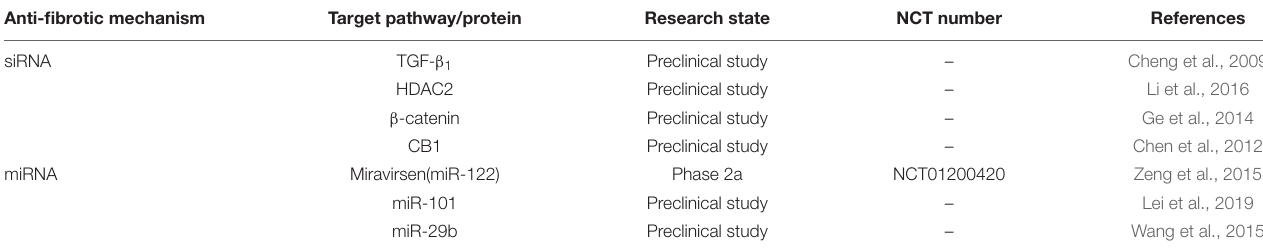
TABLE 4 | siRNA and mRNA for the treatment of hepatic